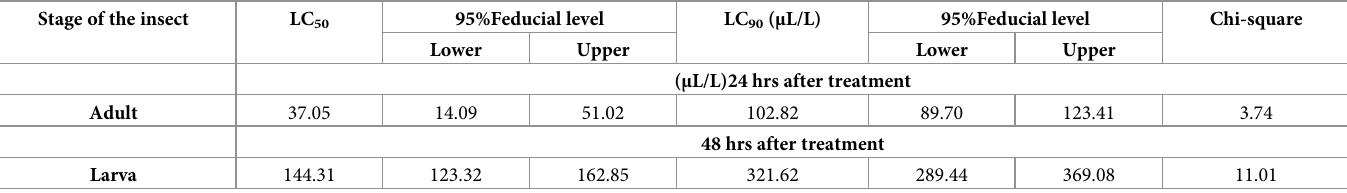
Table 4. Lethal concentration of essential oil from C . citrinus against T . castaneum adult and larvae. Stage of the insect